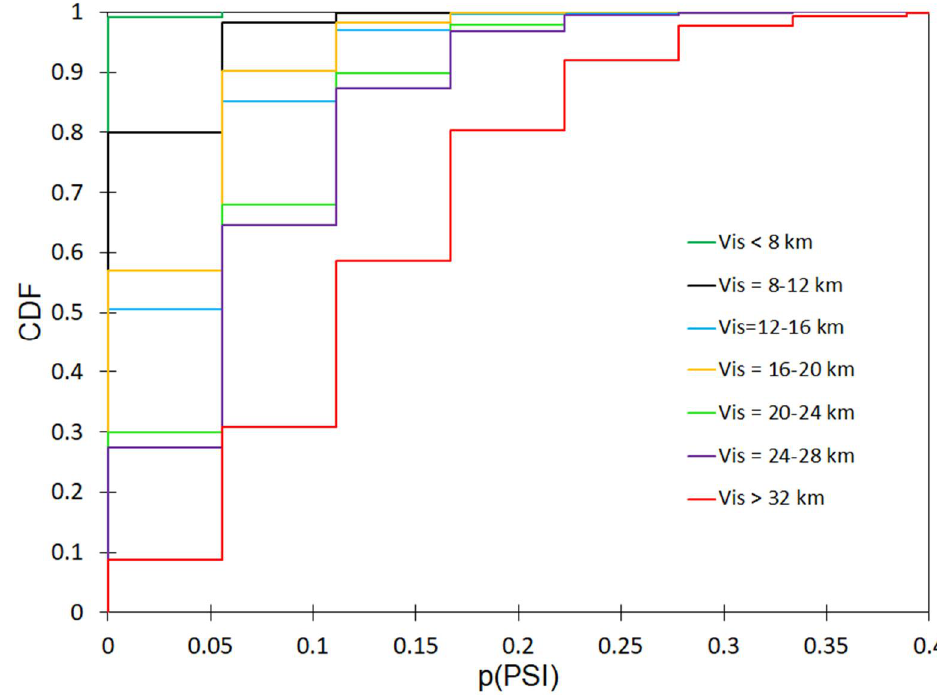
Figure A32. Effect of visibility on the incidence of low spring mortality for dry days.